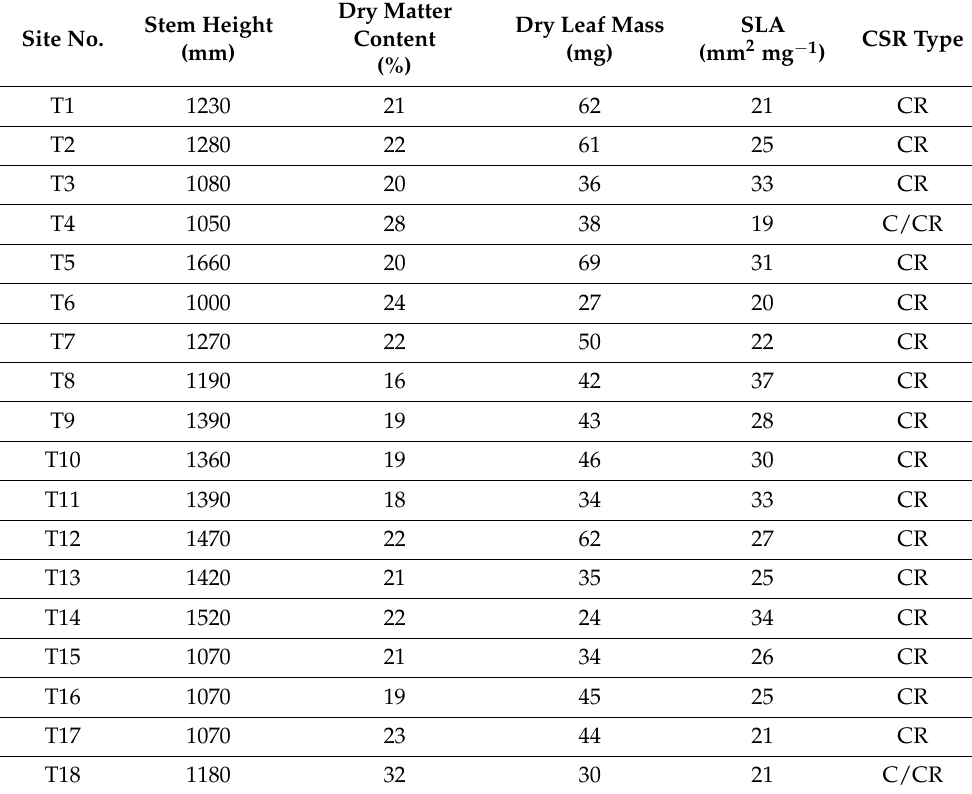
Table 3. Determined CSR types for populations of E. annuus across 18 sites.